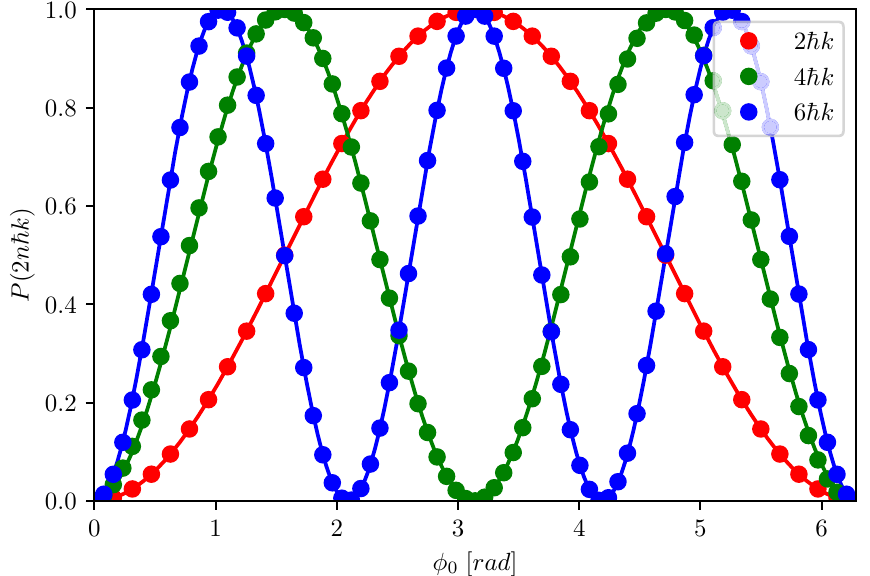
Figure 3. Scan of Mach–Zehnder interferometer phase for different Bragg transition orders of 2 (cid:31) k (red dots), 4 (cid:31) k (green dots) and 6 (cid:31) k (blue dots). The phase shift is applied as a laser phase jump φ 0 0, 2 π at the last ∈ [ ] 50 µ s, respectively. 25 µ s and τ Bragg pulse. The lengths of the Gaussian splitting and mirror pulses are τ bs m = = 0.01 (cid:31) k. The corresponding Rabi frequencies for the The initial momentum width of the atomic sample is σ p = higher order Bragg transitions were found by optimising for an ideal 50 : 50 population splitting of the π 2 pulse. 2 (cid:31) k transition is (cid:31) 2 (cid:31) 3.7 ω 8.4 ω 1.0573 ω This leads to (cid:31) 4 (cid:31) k r and (cid:31) 6 (cid:31) k = r . The Rabi frequency for the r . k = = The solid lines are the respective fringe scan fits from which the phase shifts and contrasts are directly